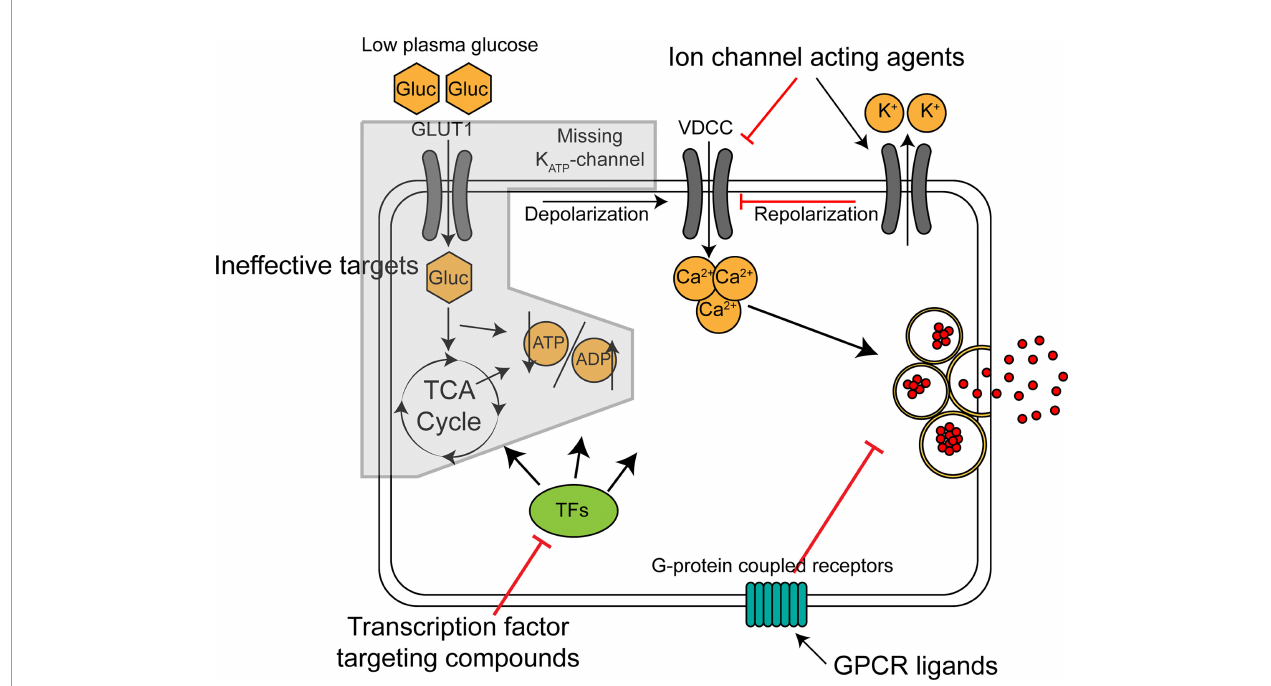
FIGURE 1 | Mechanism of action for classes of potential antihypoglycemic agents for treatment of K ATP -channel related CHI. Broad, schematic depiction of insulin secretion machinery in K ATP -channel de fi cient beta cells in low glucose. GLUT1, glucose transporter; Gluc, glucose; VDCC, voltage-dependent calcium channel; TCA cycle, tricarboxylic acid cycle; TFs, transcription